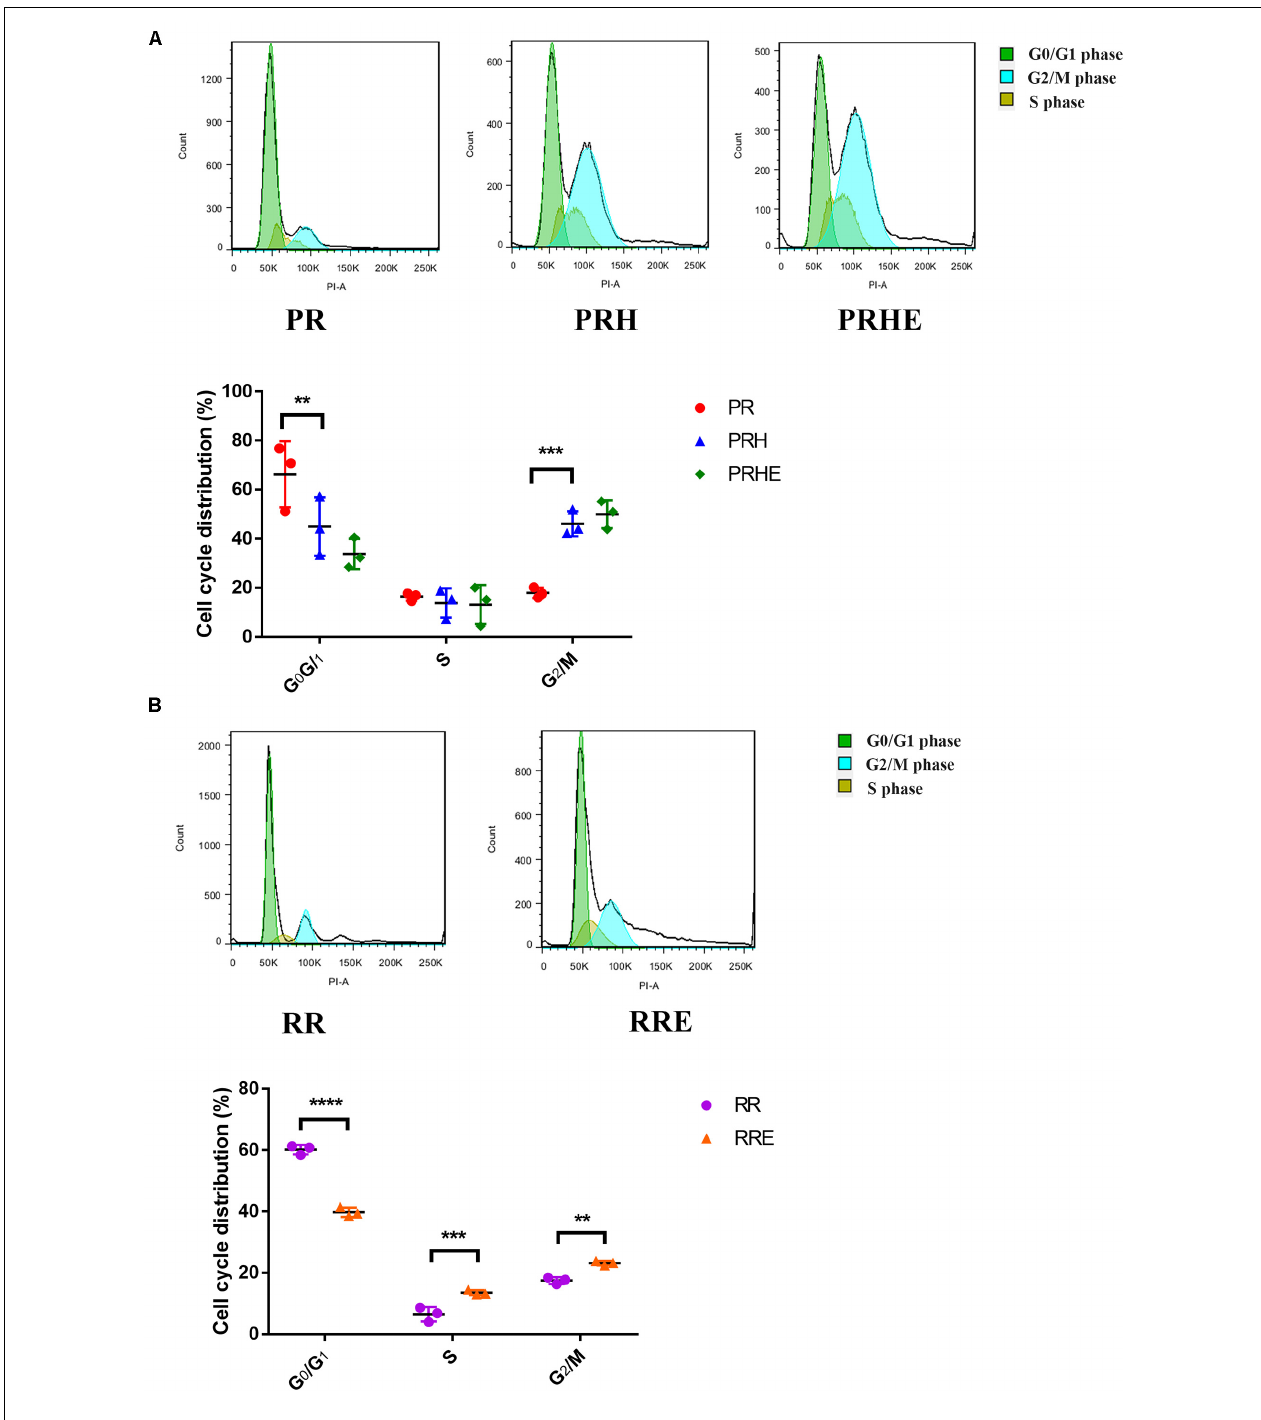
FIGURE 4 | The cocultured ESCs promoted the G 1 /S phase transition in replicative senescent RPE cells. (A) Proportion of cell cycle distribution in the PR, PRH, and PRHE groups, as assessed by flow cytometry ( n = 3 biological repeats). (B) Proportion of cell cycle distribution in the RR and RRE groups, as assessed by flow cytometry ( n = 3 biological repeats). Data are presented as the mean ± SD. ∗∗ P < 0.01; ∗∗∗ P < 0.001; ∗∗∗∗ P < 0.0001.